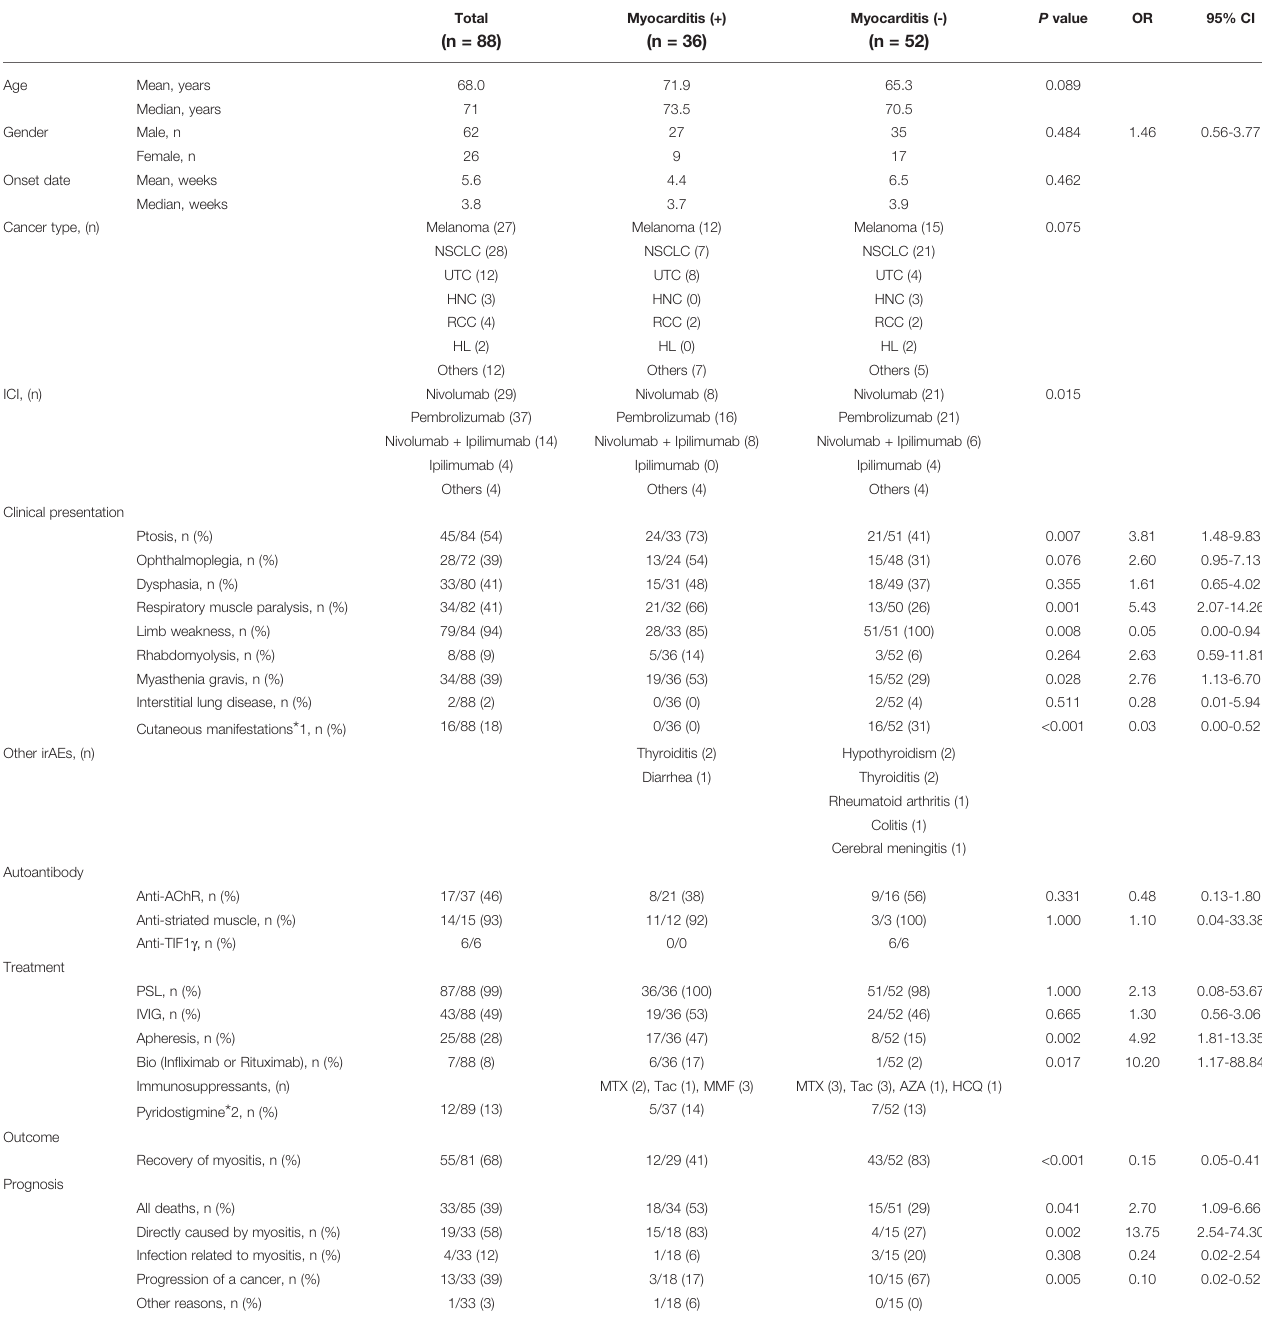
TABLE 2 | Clinical features and prognosis of immune checkpoint inhibitor-related